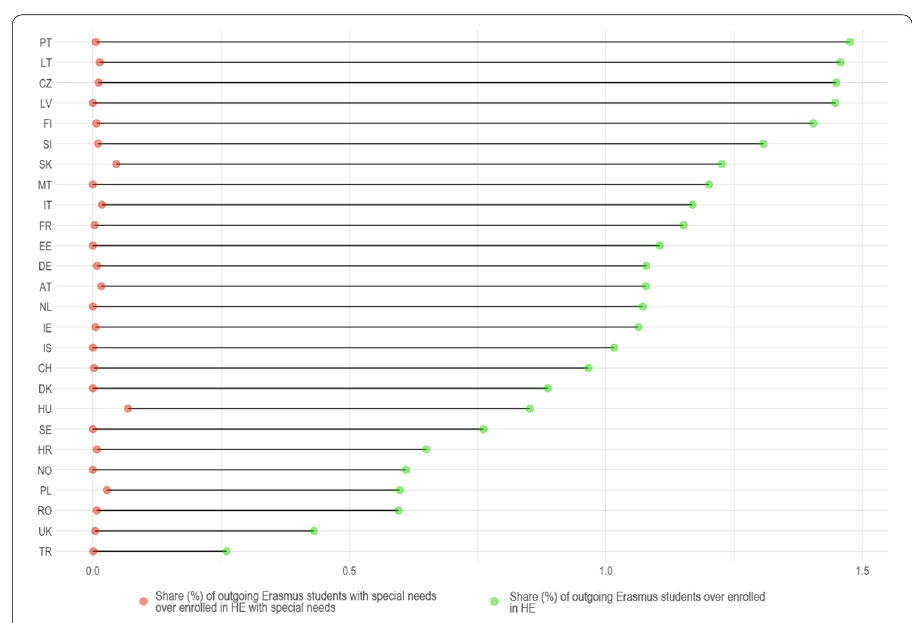
Fig. 2 Share of Erasmus students over total population of students in HE in 2013. Labels correspond to ISO alpha-2 country codes. Countries are displayed in descending order by share of Erasmus students over enrolled in HE (green dots). Belgium, Bulgaria, Cyprus, Spain, Greece, Liechtenstein, Luxembourg, Republic of Macedonia are not displayed due to missing information on the number of students with impairments in HE. Information on the population of students with disabilities in HE for the UK was retrieved from the Higher Education Statistics Agency for the year